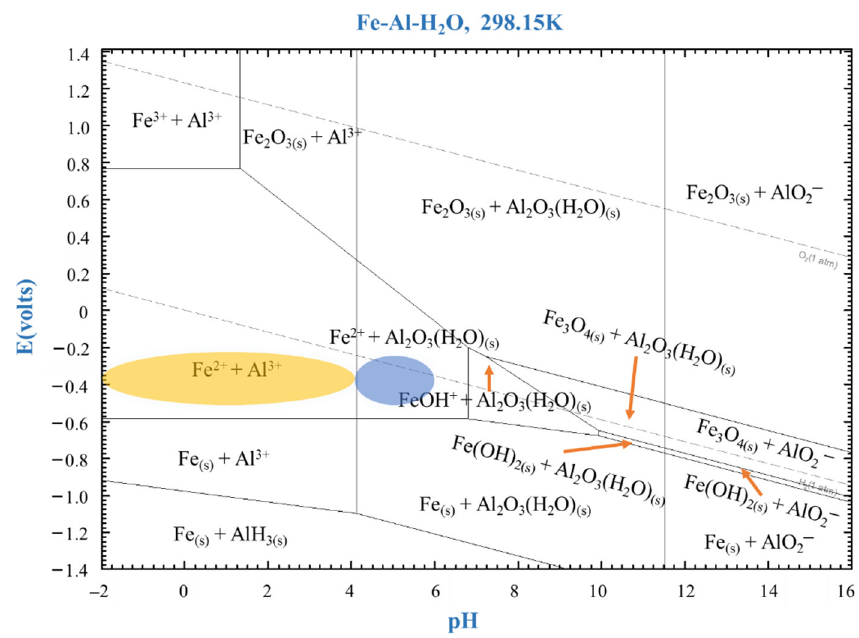
Figure 5. Pourbaix diagram of the Fe-Al-H 2 O system calculated at 298.15 K using FactSage software. A schematic diagram of the initiation and development of localized corrosion